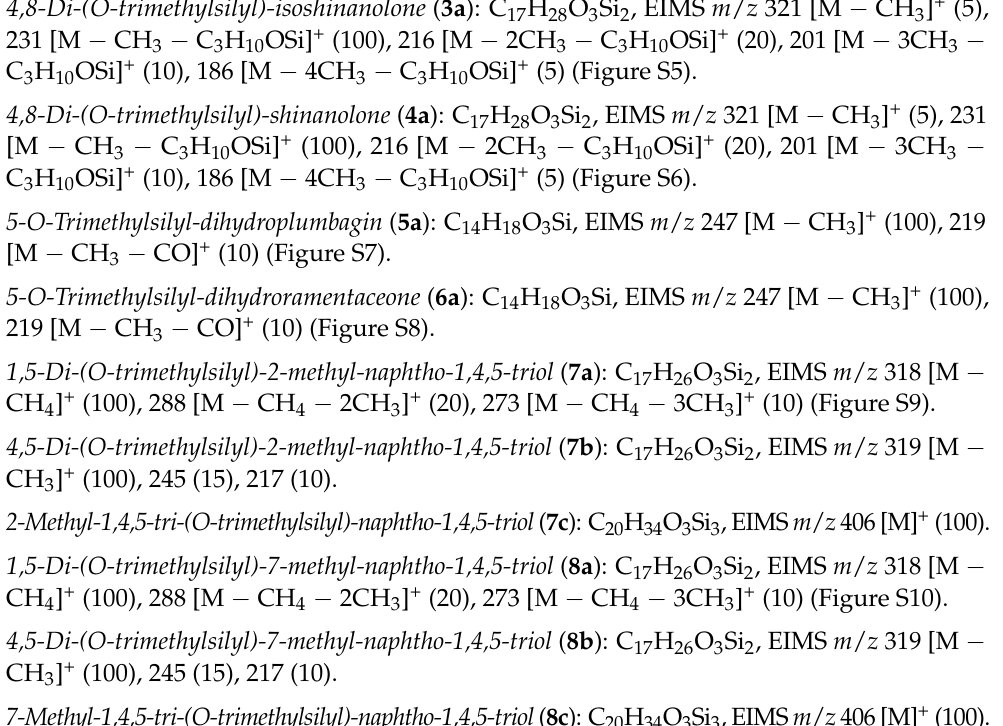
mentaceone ( 6 ), Figure S3: MS of TMS derivative compound 1a , Figure S4: MS of TMS derivative compound 2a , Figure S5: MS of TMS derivative compound 3a , Figure S6: MS of TMS derivative compound 4a , Figure S7: MS of TMS derivative compound 5a , Figure S8: MS of TMS derivative compound 6a , Figure S9: MS of TMS derivative compound 7a , Figure S10: MS of TMS derivative com- pound 8a , Figure S11: TLC of extracts from selected Drosera species, Table S1: MS data of identified naphthoquinone